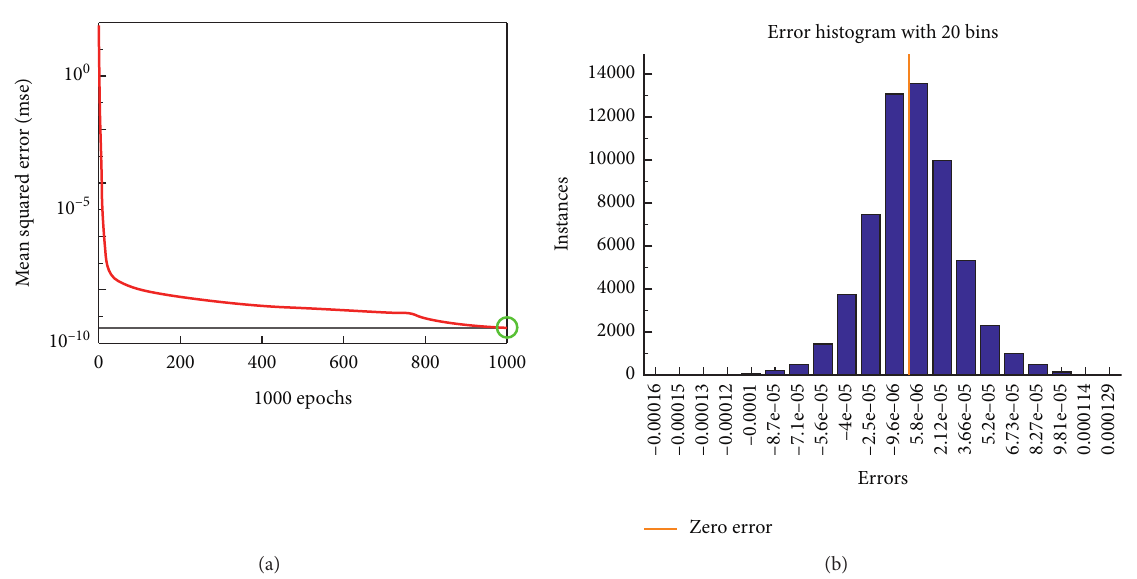
Figure 25: For tested network: (a) performance (mse values), (b) error histogram.